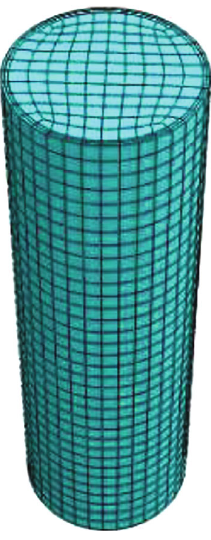
Figure 9: Finite element